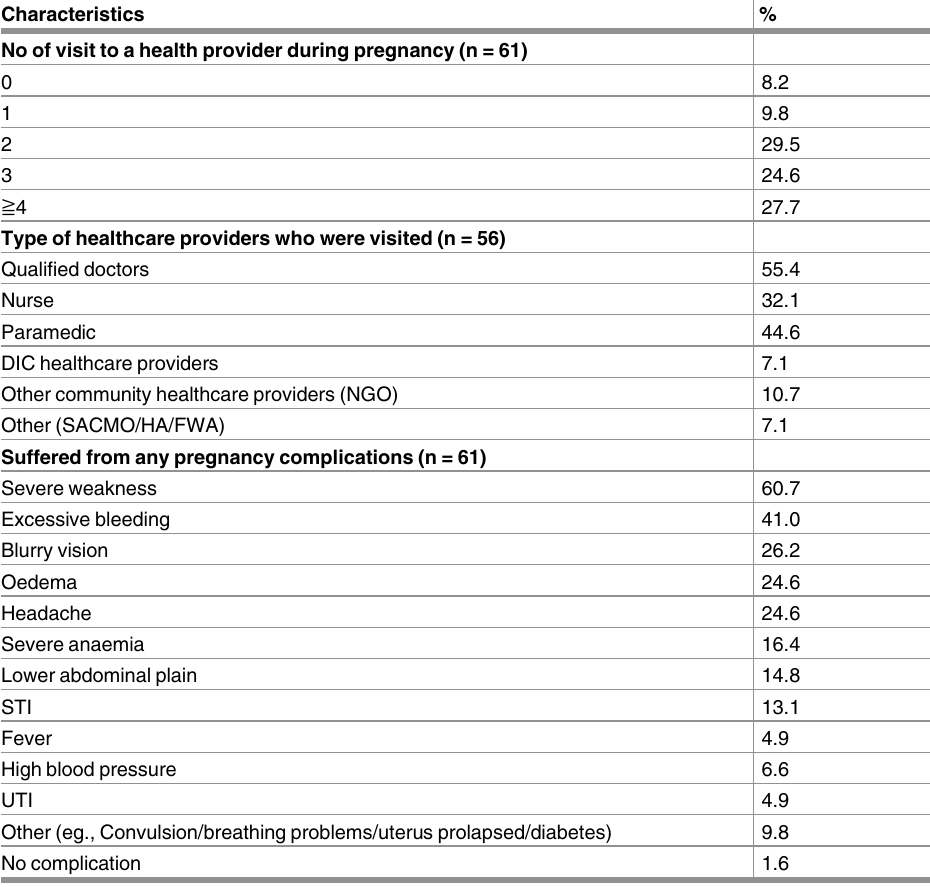
Table 4. Antenatal care characteristics of FSWs with a birth in last year.